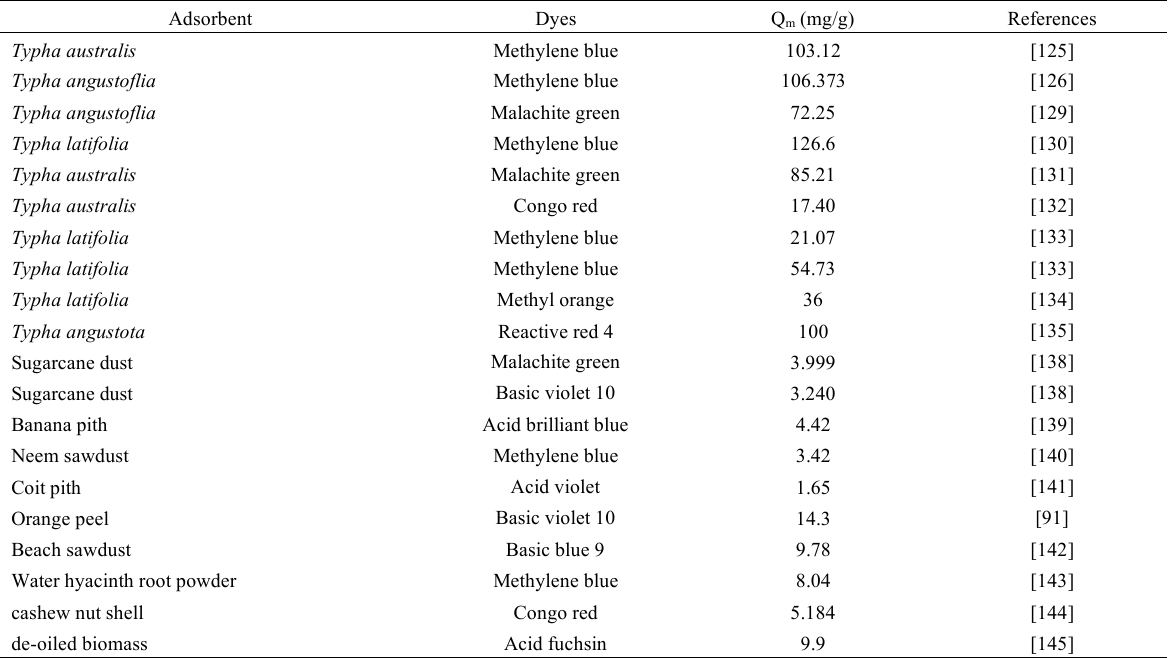
Table 6. Reported adsorption capacities q m (mg/g) for the removal of dyes by different Typha biomaterials and other agricultural wastes